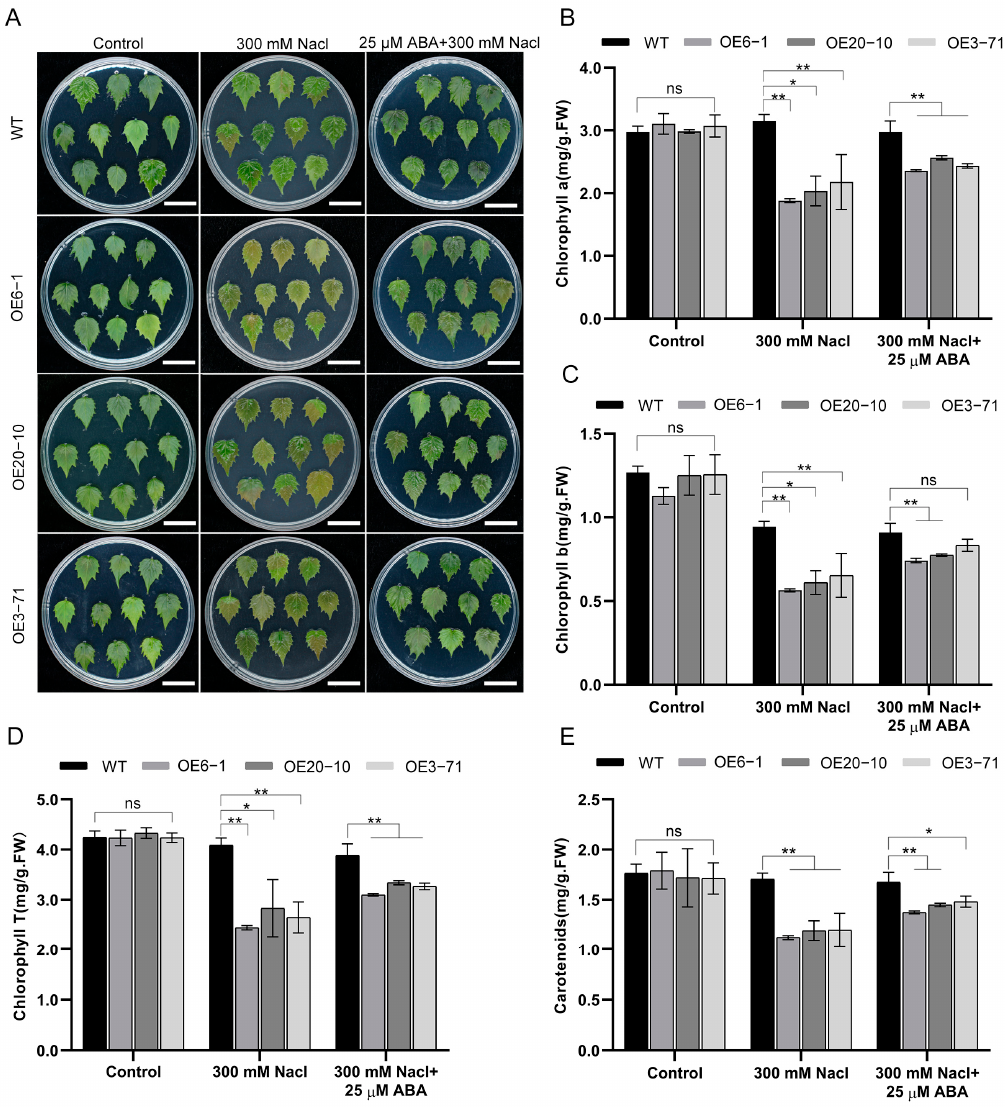
Figure 6. Exogenous ABA affects the salt tolerance of CbWRKY27-overexpressing plants. ( A ) Phe- notypic analysis of detached leaves of transgenic plants and WT with 0 mM NaCl, 300 mM NaCl, and 300 mM NaCl+ 25mM ABA. Measurement of ( B ) chlorophyll A, ( C ) chlorophyll B, ( D ) total chlorophyll, and ( E ) carotene. Bar = 4 cm. The data represent the means ± SD ( n = 3), * p < 0.05 and ** p < 0.01 using Student’s t-test. The six-week-old seedlings were subjected to treatment. To clarify the role of CbWRKY27 in regulating salt tolerance via an ABA–dependent pathway, qPCR was performed on OE6-1 and WT seedlings treated with 300 mM NaCl. Five ABA-responsive genes, including NCED3 , ABI3 , ABI5, RD22 , and RD29B, were ana-